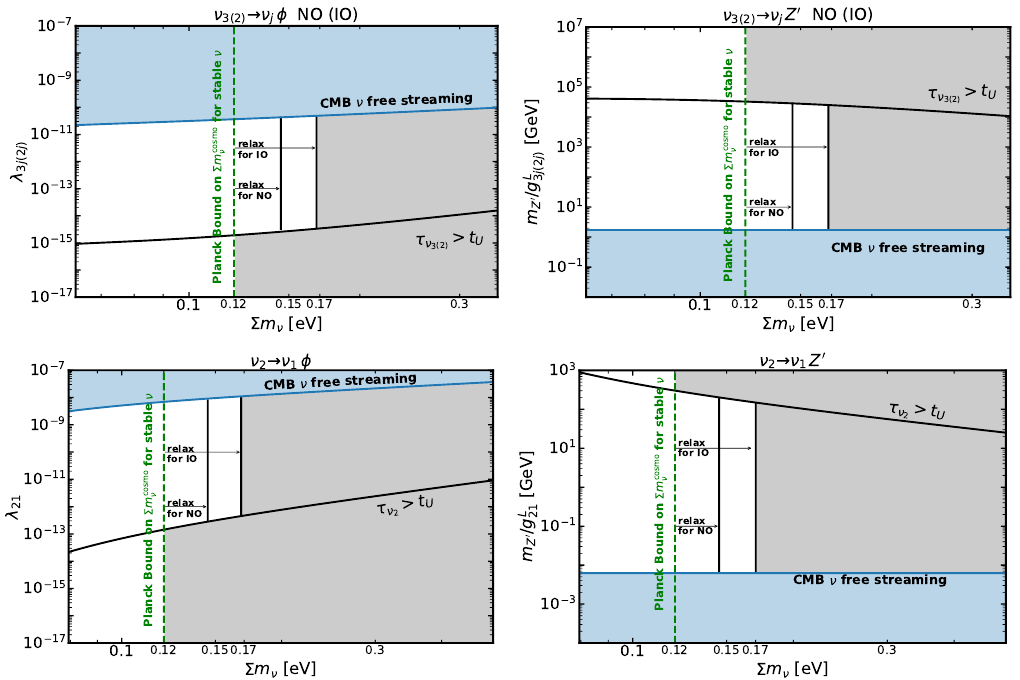
Figure 5 . Parameter space for case 2a (see figure 1). Left panel: ν i → ν j φ decays with φ being a pseudoscalar boson. Right panel: ν i → ν j Z 0 decays. Here we have assumed that all the couplings are different from zero and all neutrinos decay except the lightest one. The blue region is excluded by the constraint on invisible neutrino decays from Planck CMB observations [22]. In dashed green we highlight the current bound on P m ν within the Λ CDM [12] and stable neutrino framework. The arrows indicate to what extent it can be relaxed, see also figure 4. The grey region is excluded by the bound P m cosmo